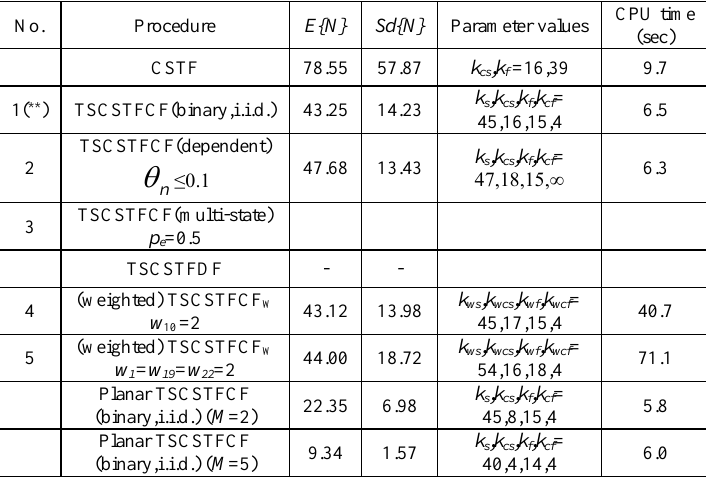
Table 7.Optimal values of the expected number of tests for different